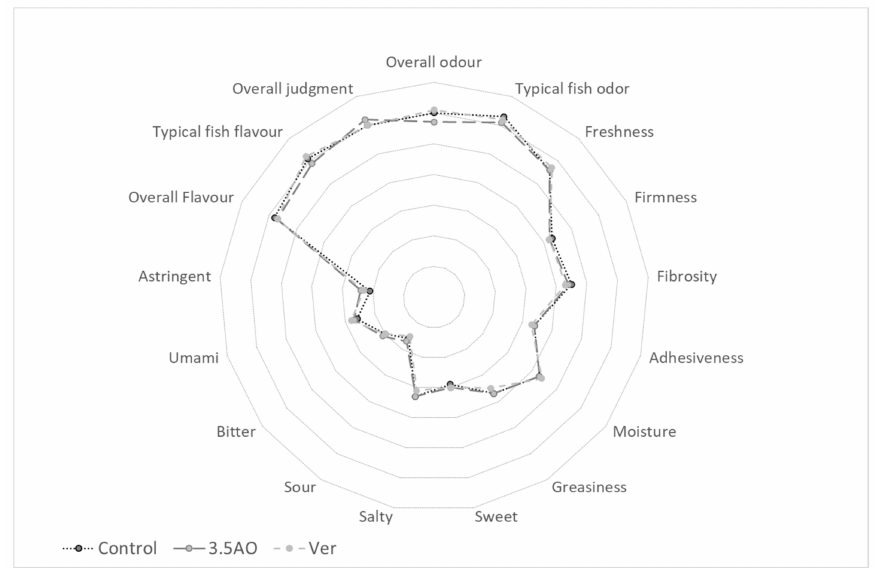
Figure 2. Overlap of sensory description of fillets from gilthead seabream fed with the different diets. C: Positive control; 3.5AO: 3.5% microalgal oil; 0.7AO: 0.7% microalgal